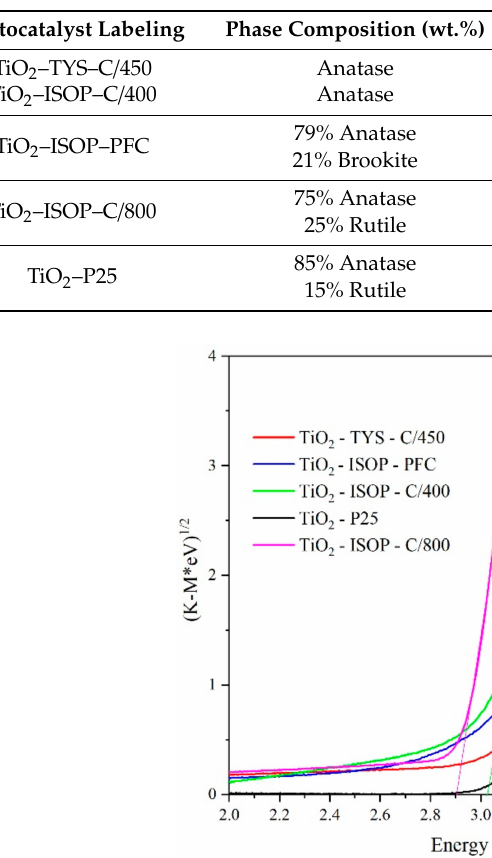
Table 2. Structural properties of investigated photocatalysts.